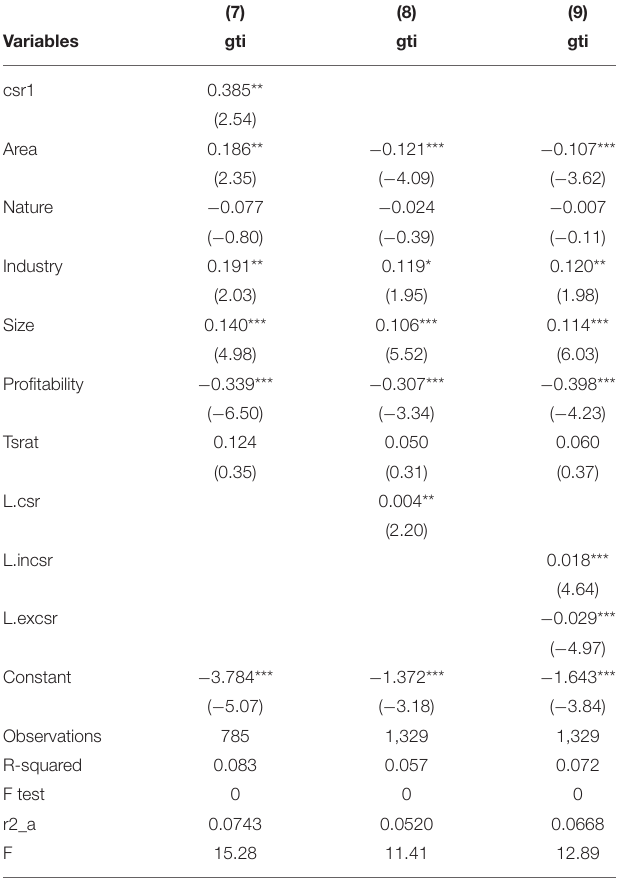
TABLE 10 | Results of robustness